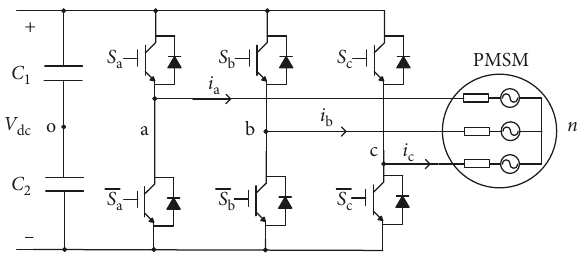
Figure 1: PMSM drive system with three-phase two-level